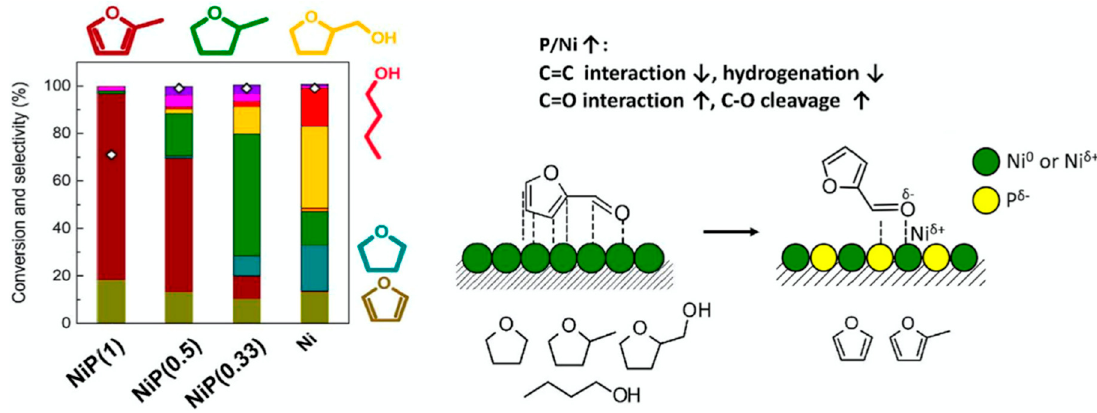
Figure 12. Effect of P on furfural HDO over Ni and nickel phosphide catalysts. Reprinted with permission from Ref. [98]. Copyright 2018 Wily Online.